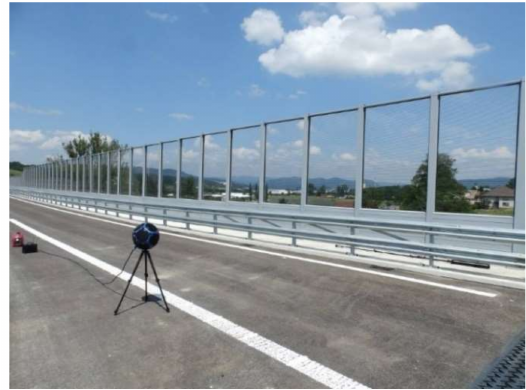
Figure 5. Regulated artificial noise